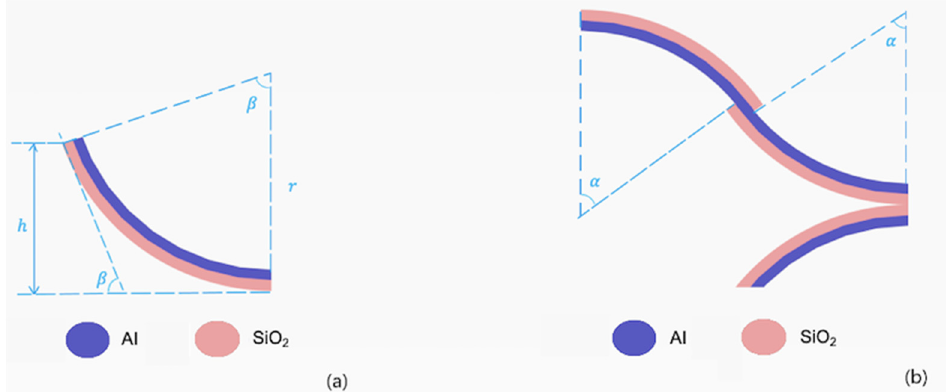
Figure 4. Illustration of the electrothermal bimorphs. ( a ) An Al/SiO 2 bimorph cantilever. ( b ) A double S-shaped inverted-series-connected (ISC) bimorph actuator.